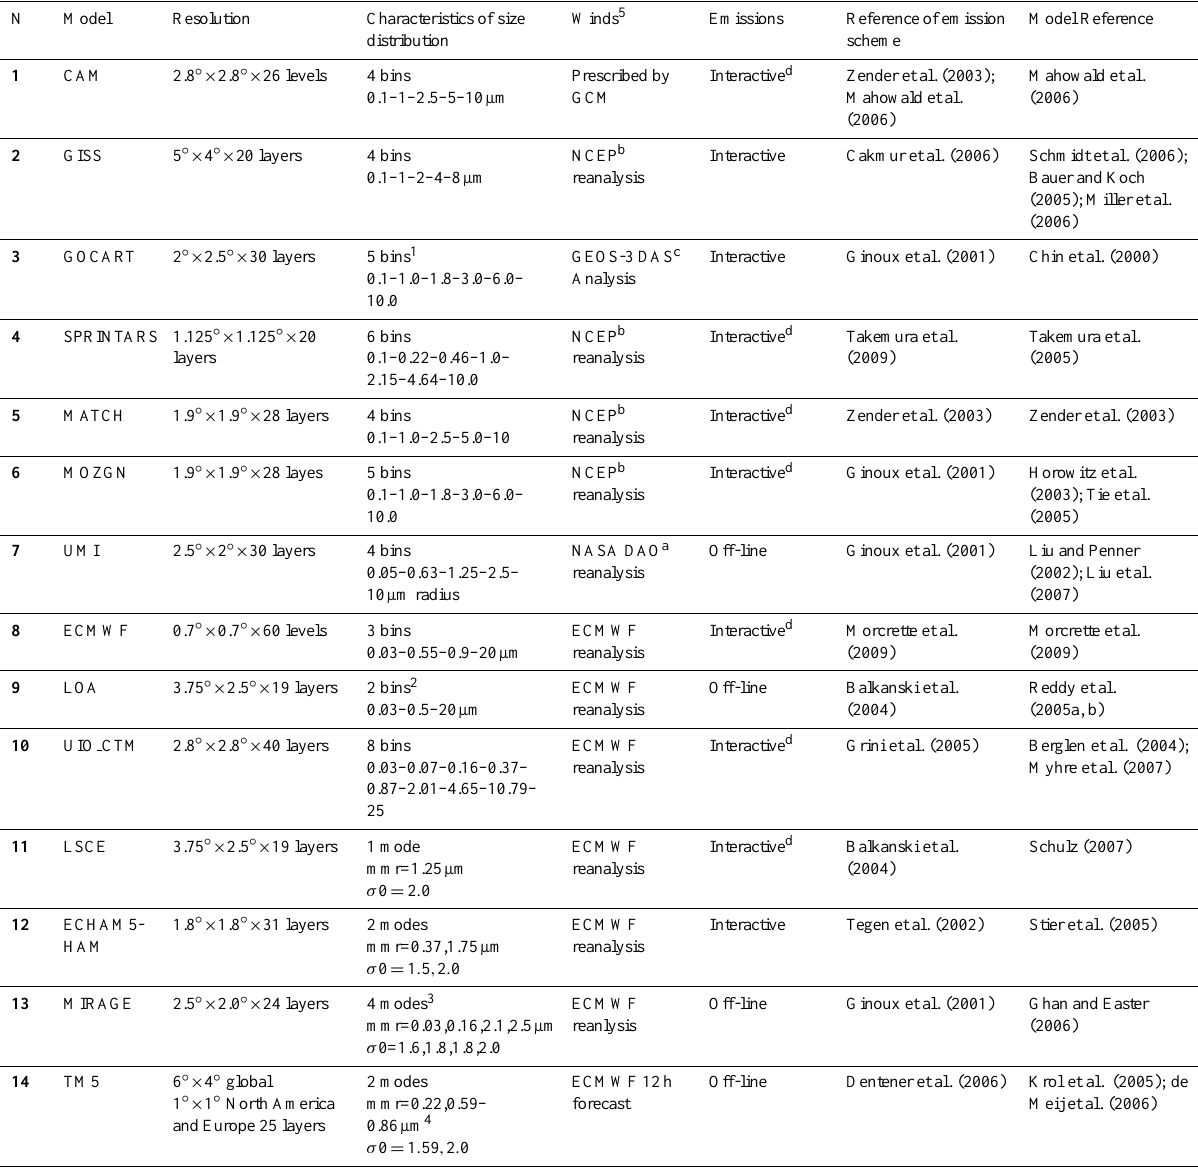
Table 1. Description of the global models considered in this study. Aerocom Median is not included in this table since it is constructed at every grid point and for every month by computing the local median from the models specified in Table 2. Models have been grouped according to their size ranges; models CAM to UMI simulate dust aerosols in the size range 0.1–10µm, models ECMWF and LOA in the size range 0.03–20 µm and UIO CTM in the range 0.05–25 µm. Models LSCE, TM5, ECHAM5-HAM and MIRAGE describe dust aerosols through 1, 2, 2 and 4 modes